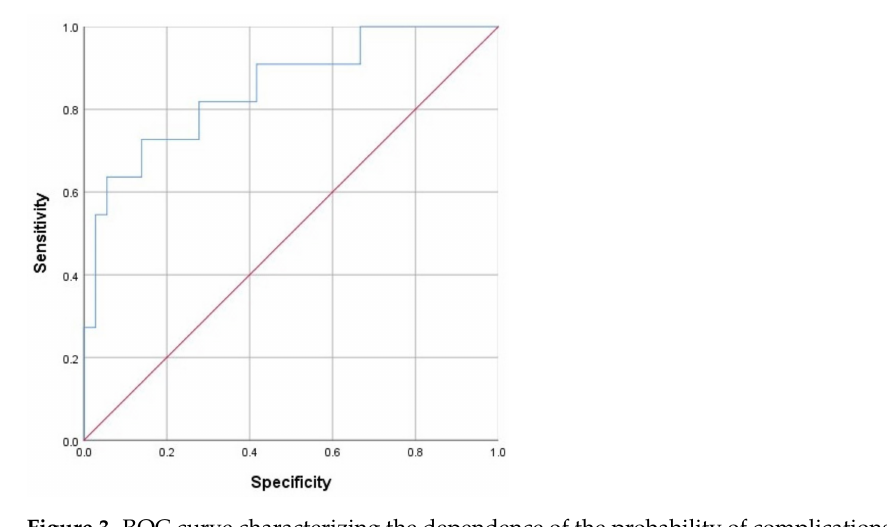
Figure 3. ROC curve characterizing the dependence of the probability of complications in the early postoperative period on the values of the P logistic